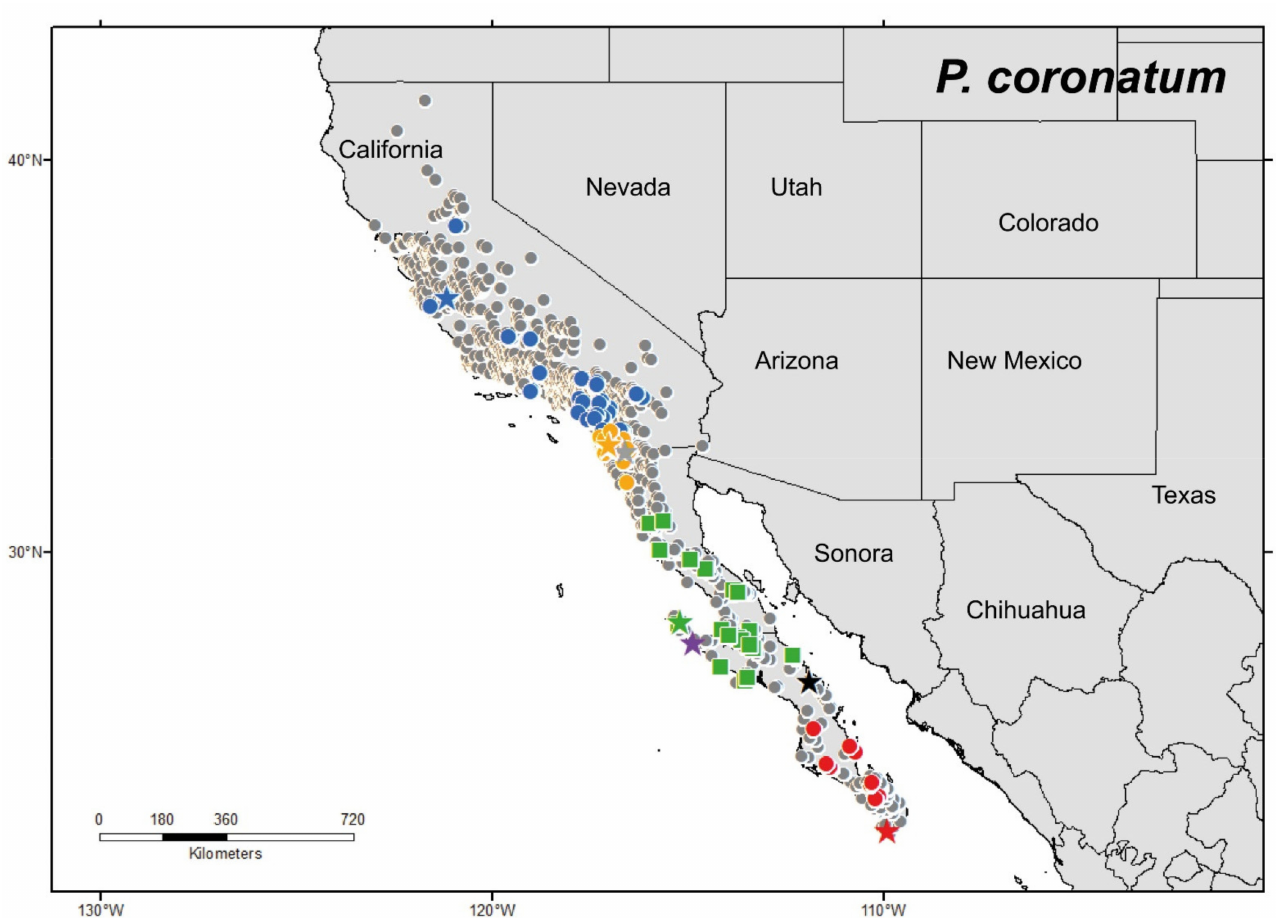
Figure 9. Map showing distributional records of Phrynosoma coronatum . Blue circles = genetically confirmed records of P. c. frontale ; orange circles = genetically confirmed records of P. c. blainvillii; green squares = genetically confirmed records of P. c. cerroense; red circles = genetically confirmed records of P. c. coronatum; gray circles = records that have not been genetically confirmed; blue star = type locality of P. frontale ; orange star = restricted type locality of P. blainvillii ; gray star = type locality of P. ochoterrenai ; green star = type locality of P. cerroense and P. schmidti ; purple star = type locality of P. jamesi ; black star = type locality of P. wigginsi ; red star = restricted type locality of Agama coronata